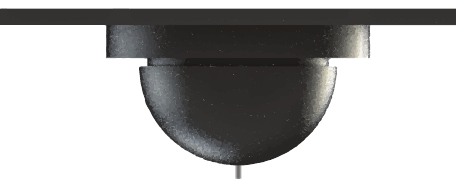
Figure 5. Side view of top part of air